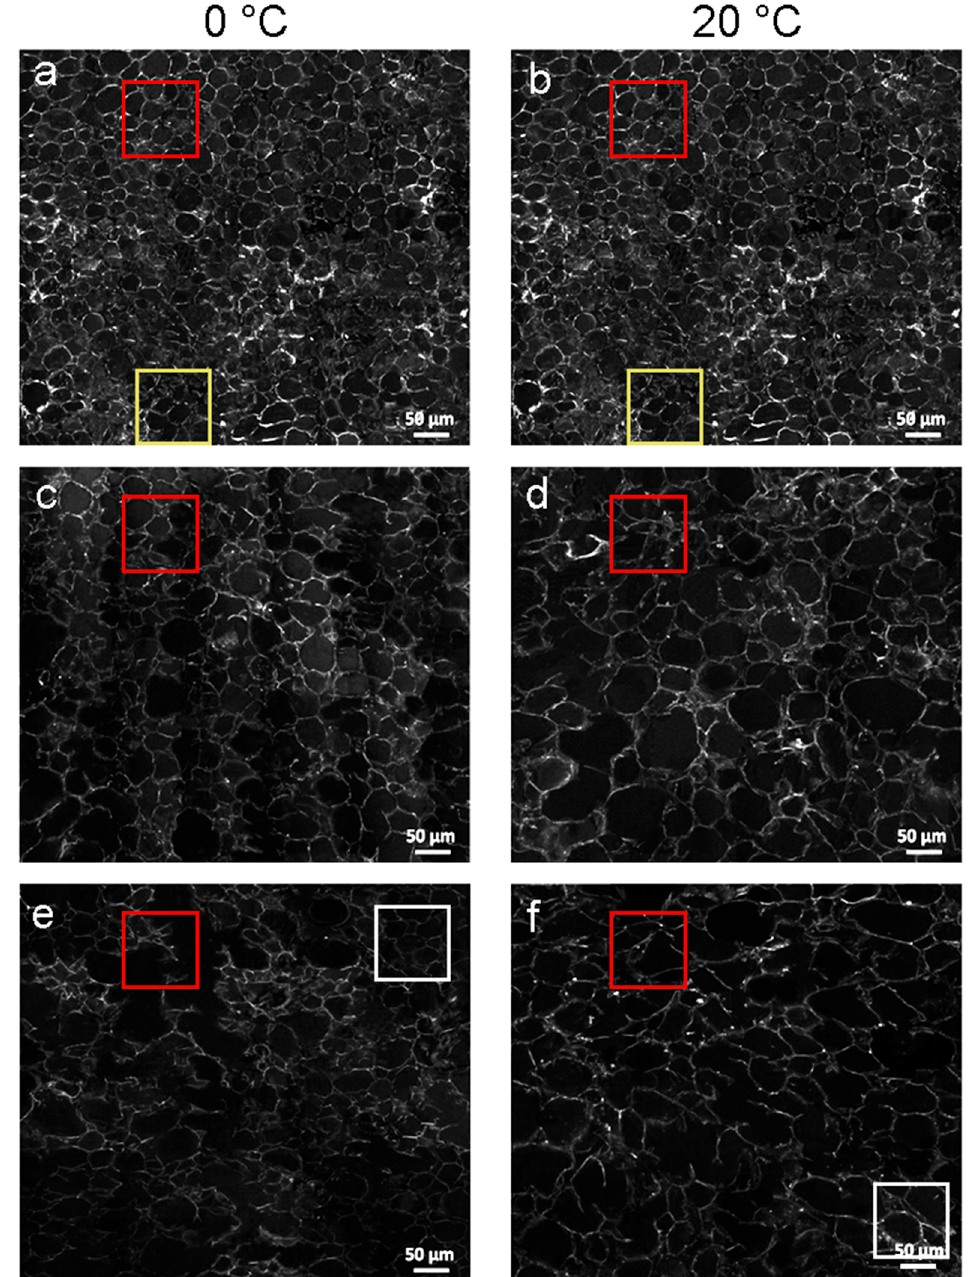
Figure 4. SRS hyperspectral images of peach parenchyma tissue during the postharvest storage at 0 °C and 20 °C. Areas in red box were selected to show the details of the SRS hyperspectral images in Figure S4. Each storage temperature had three stages of data sampling, namely 0, 30, and 60 d for the storage at 0 °C ( a , c and e ), and 0, 15, and 30 d ( b , d and f ) for the storage at 20 °C. Areas in yellow box ( a and b ) were selected to show cells with relaxing and irregular cell walls at the initial storage. Areas in white box ( e and f ) were selected to show cells still having integrate and regular cell walls at the late stage. Since 0 d is the starting point of the postharvest storage, images of 0 °C ( a ) and 20 °C ( b ) at 0 d were the same as they were obtained from the same samples.